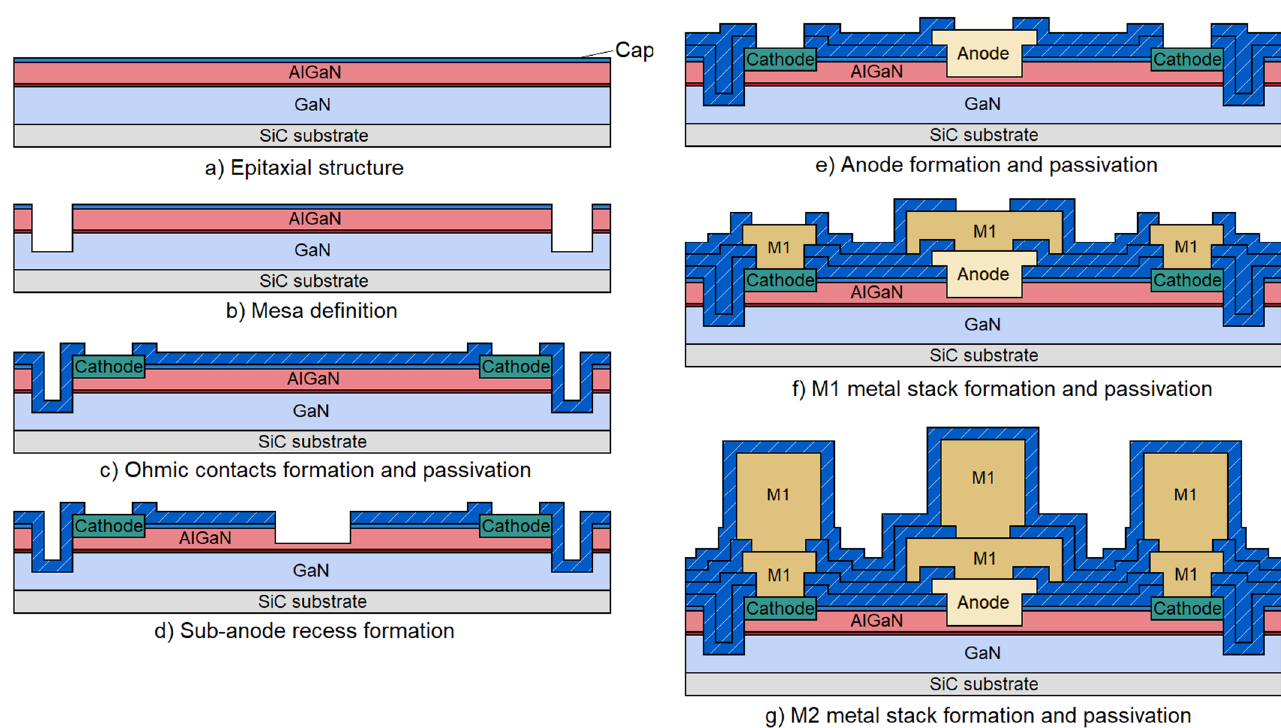
Figure 1. AlGaN/GaN lateral SBD fabrication-process flow.